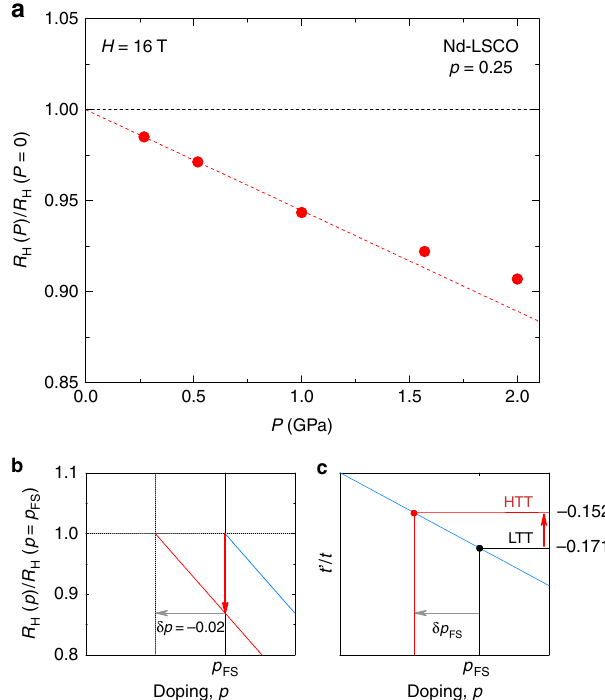
Fig. 5 Effect of pressure on p FS . a Pressure dependence of the Hall coef fi cient in Nd-LSCO at p = 0.25 > p *, normalised by its value at ambient pressure, R H (0) = 0.4 mm 3 C − 1 (Supplementary Fig. 4). The dashed line is a linear fi t through the data at low pressure, whose slope is − 6 % GPa − 1 . b Sketch of the doping dependence of R H in LSCO (Supplementary Fig. 3), normalised by its value at p FS (blue line). The red line illustrates the effect of shifting p FS down in doping by an amount δ p FS = − 0.02 (grey arrow): R H decreases by ~13 % (red arrow). This is the amount by which R H decreases in Nd-LSCO under 2.0 GPa, for p > p * ( a ). c Sketch of the theoretical dependence of p FS on the band – structure parameter t ’ / t . For a given value of t ’ / t , p FS is given by the blue line, which separates the regions where the cuprate Fermi surface is electron-like (above) and hole-like (below). Our band – structure calculations for Nd-LSCO yield t ’ / t = − 0.171 in the LTT structure (black) and t ’ / t = − 0.152 in the HTT structure (red) (Supplementary Fig. 2), so that p FS is expected to decrease (grey